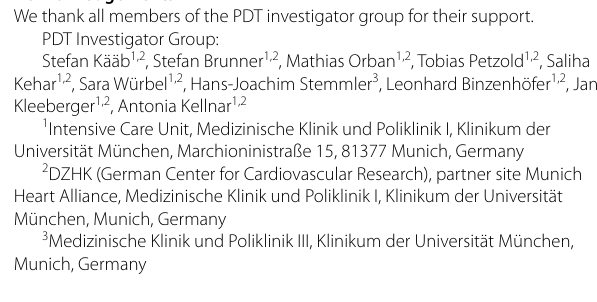
tion. Table S3. Procedural related complications during and after PDT (based on seven treatment groups). p -values < 0.05 were considered as significant; ns: